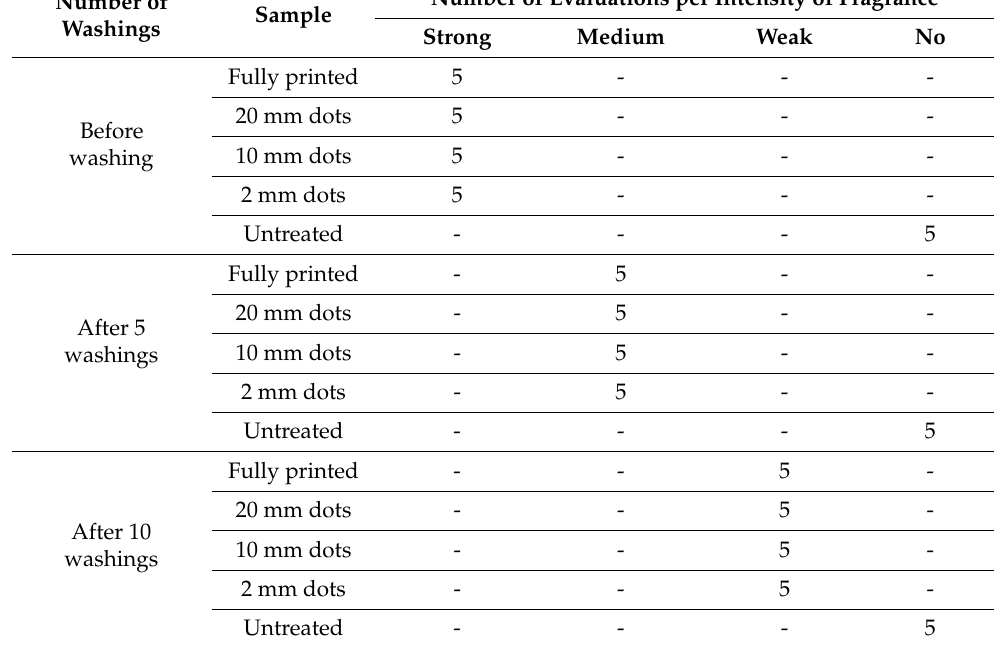
Table 3. Evaluation of